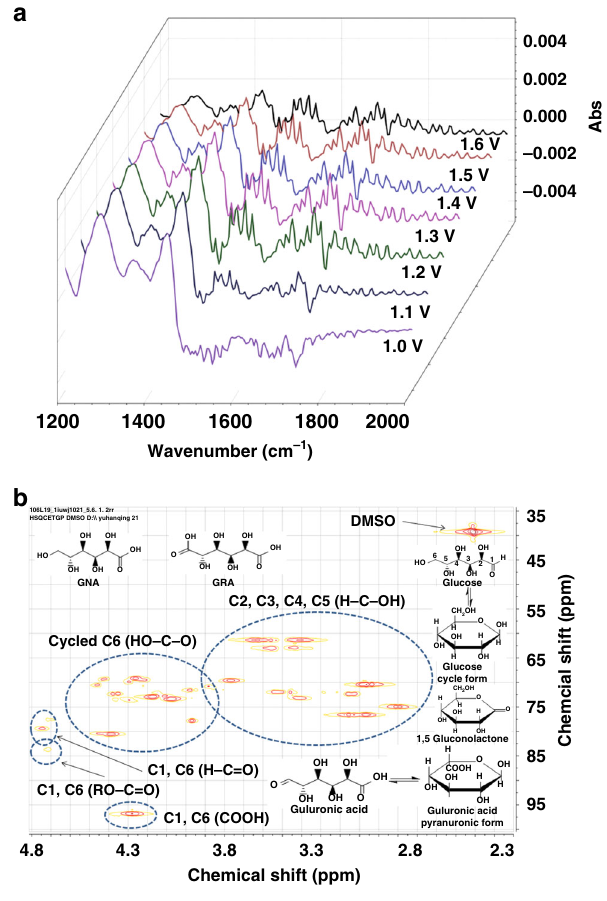
Fig. 6 Analysis of the possible products of the glucose electrolysis process. a In situ ATR-FTIR spectra collected at a potential ranging from 1.0 to 1.6 V vs. RHE with a step of 100 mV. b 2D HSQC NMR spectrum of the reaction solution after 6-h electrolysis (initial glucose concentration: 10 mM, potential: 1.3 Fig. 6b. The LC-MS analytic results of the reaction solution after 6-h electrolysis (Supplementary Fig. 22) further con fi rm the presence of GNA, GRA and some intermediates like 1,5- gluconolactone and guluronic acid.